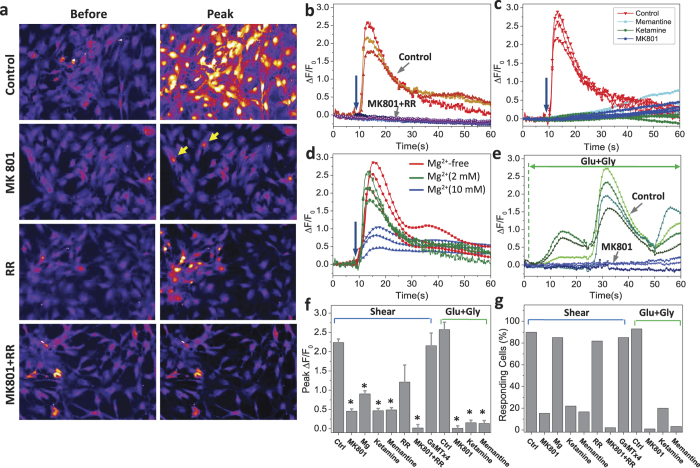
Sources of shear-activated Ca2+ increase in astrocytes using pharmacology.(a) Fluorescence images of Fluo-4 loaded astrocytes before the stimulus pulse (23 dyn/cm2, 10 ms) and 6 s later at the peak of the response under control conditions and with treatments of various inhibitors. Yellow arrows indicate the responding cells. (b) Time dependent changes in Ca2+ in controls and with a mixture of MK-801 (10 μM) and Ruthenium red (30 μM). Each trace was measured from selected single cell. The shear stimulus was applied at the time indicated by the arrow. The data show that the mixture completely blocked the Ca2+ response. (c) The Ca2+ response in cells treated with MK-801 (dark blue traces, from cells in the image of panel a, section MK-801), memantine (light blue traces), and ketamine (green traces), compared with control cells (red traces). (d) The Ca2+ response in cells treated with 0, 2 and 10 mM Mg2+, showing NMDAR sensitivity to low dose Mg2+ (2 mM) was reduced by shear stress. (e) Ca2+ response to agonists, glutamate (1 mM) and glycine (1 mM) (green curves). MK-801 (50 μM) blocked the agonist activated Ca2+ response (blue curves). (f,g) Summary of peak Ca2+ responses (f) and the number of responding cells (g) in cultures treated with different drugs. The means are from N = 200 cells from >4 experiments under each condition. Cells treated with various drugs were compared with control cells with the same stimuli (*p < 0.05). Error bars indicate s.e.m.